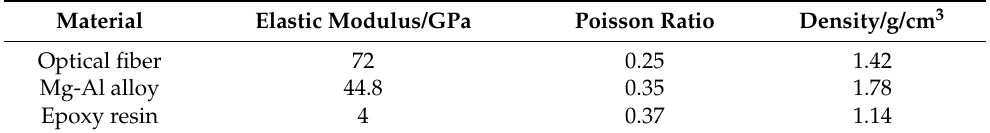
Table 3. Sensor material parameters.